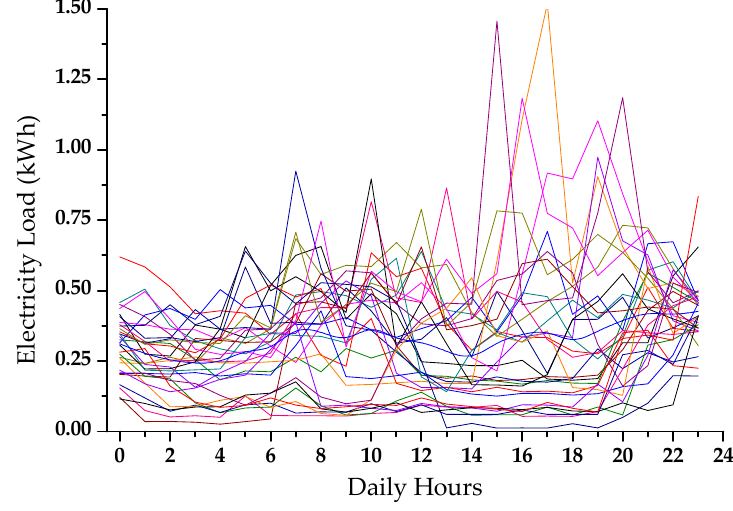
Figure 2. Daily load profile of a single household for one month.